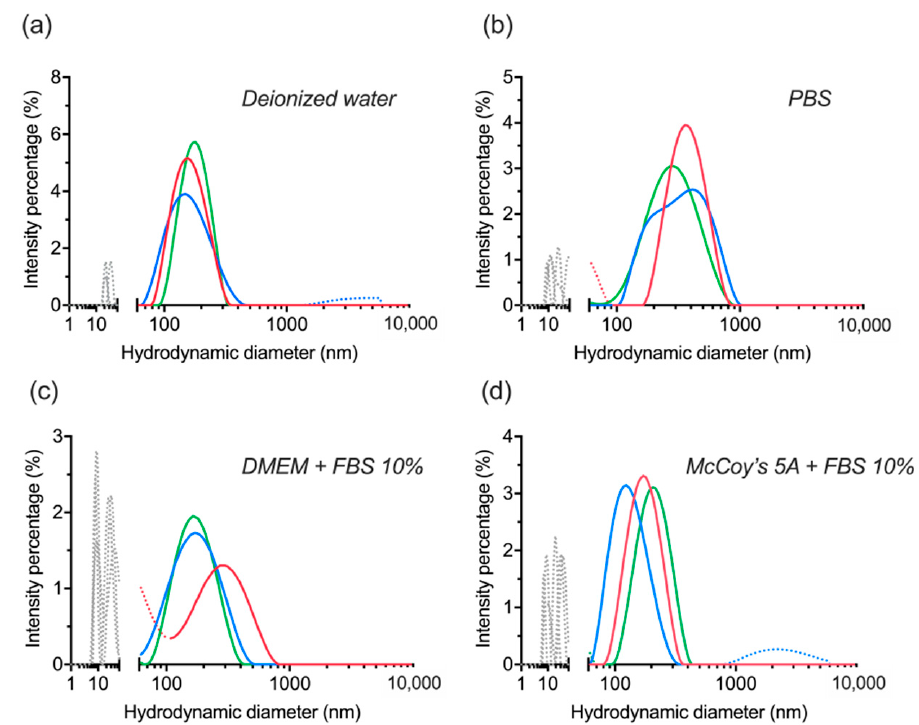
Figure 6. Evaluation of colloidal stability of lyophilized dBSA-UCNP-NOBF 4 in different buffers after one week of lyophilization and mixed by vortexing and ultrasonication, based on the results of three repeated size measurements (shown in blue, red, and green) by DLS: ( a ) in deionized water; ( b ) in PBS; ( c ) in DMEM cell culture medium supplemented with 10% FBS; ( d ) in McCoy’s 5A cell culture medium supplemented with 10% FBS. Gray and/or dotted lines below 100 nm correspond to the presence of proteins and protein aggregates; dotted lines over 300 nm are aggregates.